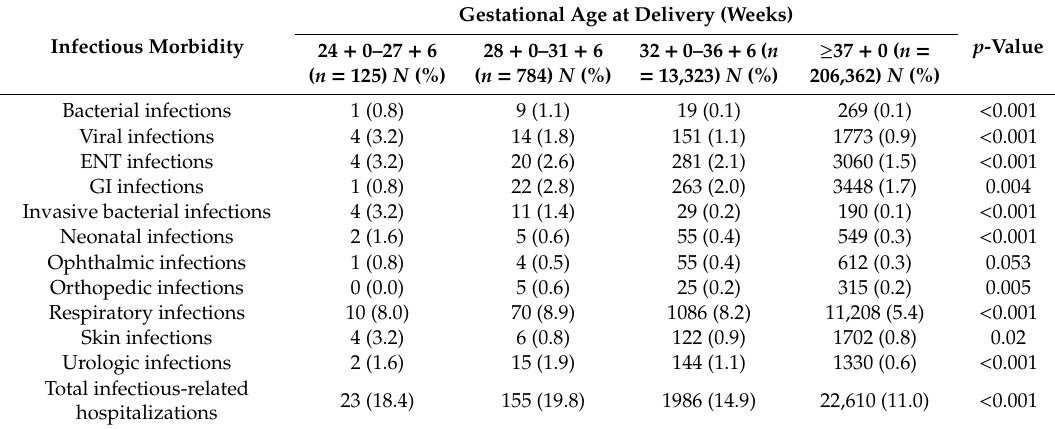
Table 2. Long-term infectious morbidities in children (up to 18 years) according to gestational age at delivery.